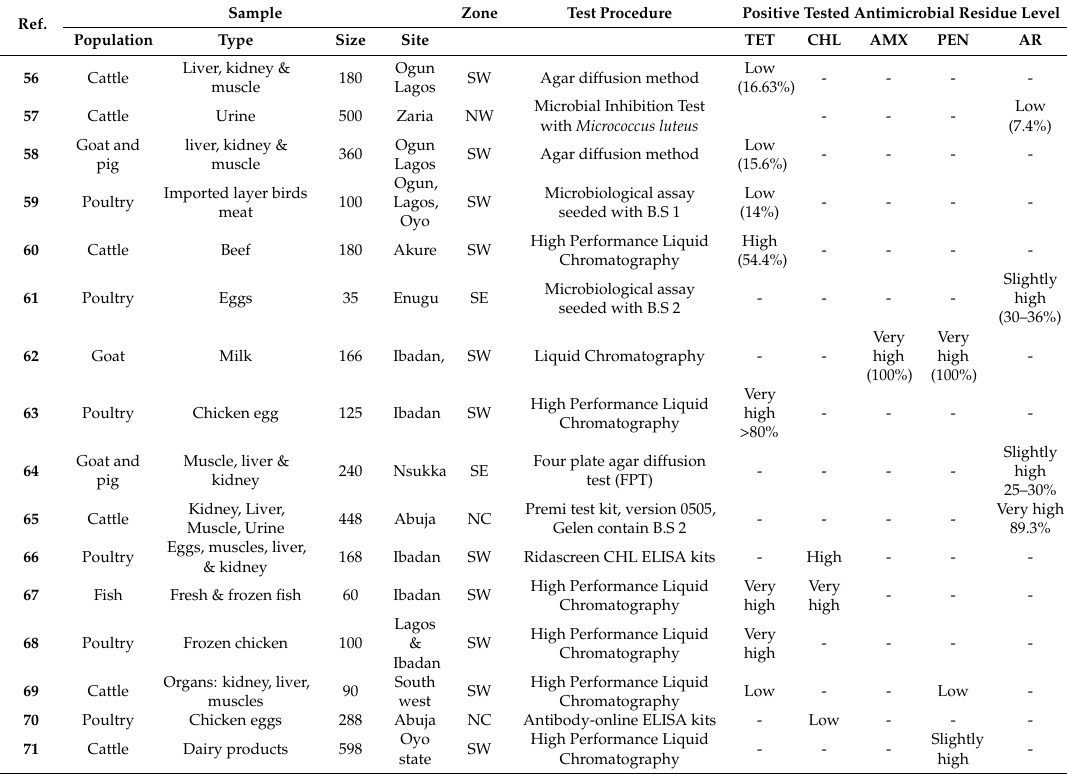
Table 5. Summary evaluation of antimicrobial residue studies. Ref.